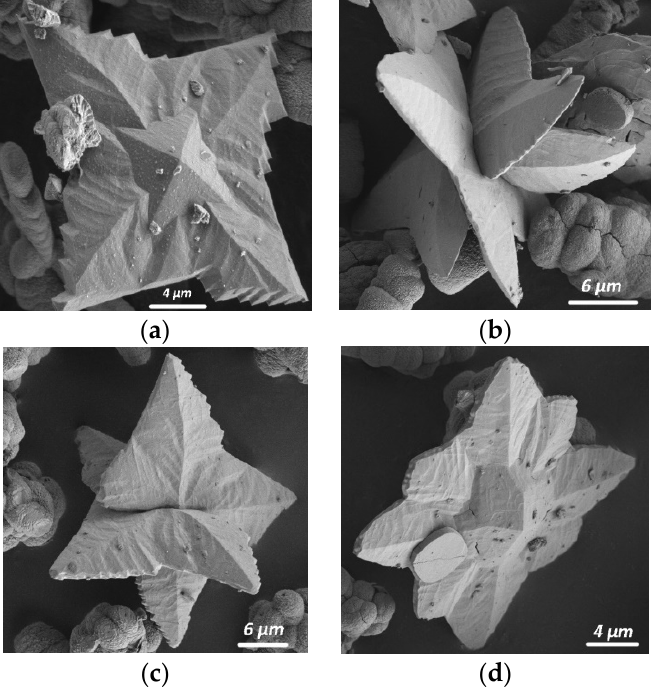
Figure 6. Weddellite crystals and aggregates obtained from solutions with citrate ions, as well as a number of other organic acids and environmental impurities: ( a ) quadrangular flat crystal with a small dipyramid in the center of the plate (Synthesis 33); ( b , c ) intergrowths of two or three flattened dipyramidal weddellite crystals along a common plane of symmetry (Syntheses 38 and 35); and ( d ) eight-fold twins, formed by two tetragonal plates intergrowing around a common axis of symmetry of the fourth order and deployed around it by 45° relative to each other (Synthesis 37).